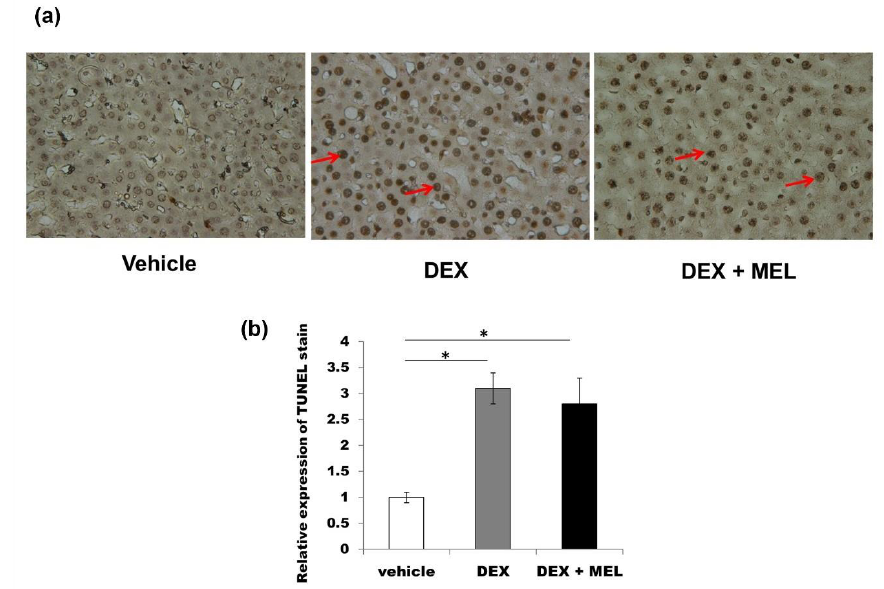
Figure 7. The extent of TdT-mediated dUTP biotin nick end labeling (TUNEL) staining was assessed for whether apoptosis was involved in this liver damage. ( a ) It was overexpressed in the DEX group compared with the vehicle group, but not decreased in the DEX+MEL group. ( b ) Semi-quantification of the TUNEL stained cells. All the results represent standard error of mean (SEM) of six animals; * p < 0.05. The letters above each represented different groups with DEX representing the prenatal dexamethasone; DEX+MEL, melatonin treatment after prenatal dexamethasone (original magnification × 400, red arrows: